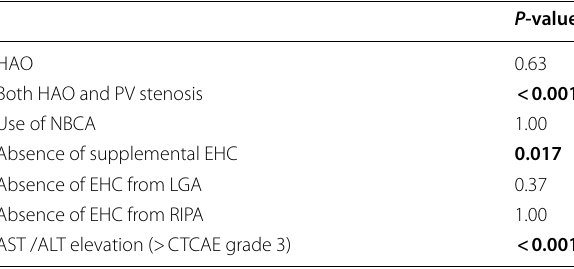
Abbreviations : ALT Alanine aminotransferase, AST Aspartate aminotransferase, CTCAE Common terminology criteria for adverse events, EHC